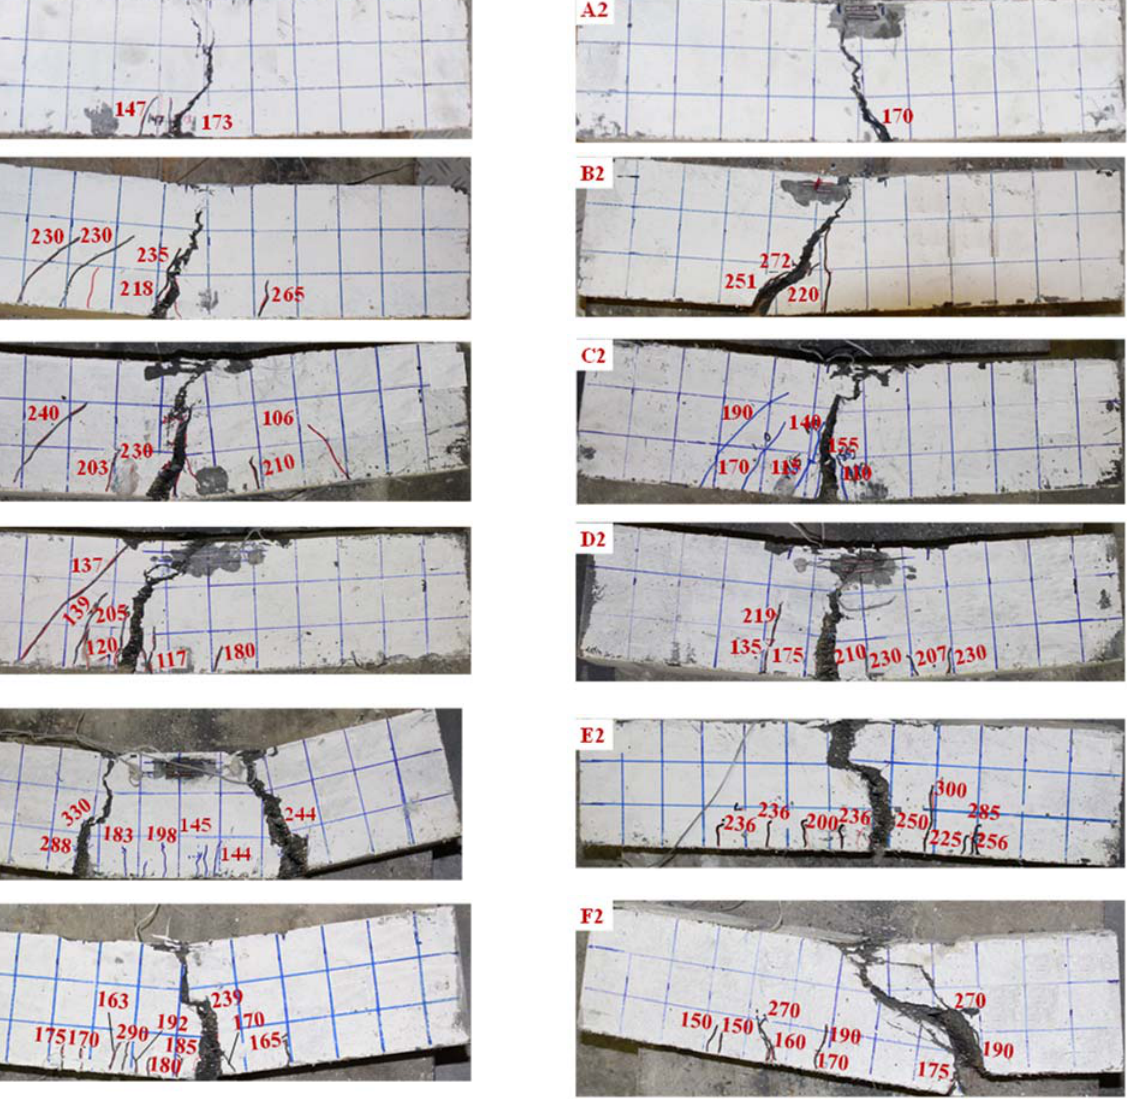
Figure 7. Modes of failure for the UHPC beams.